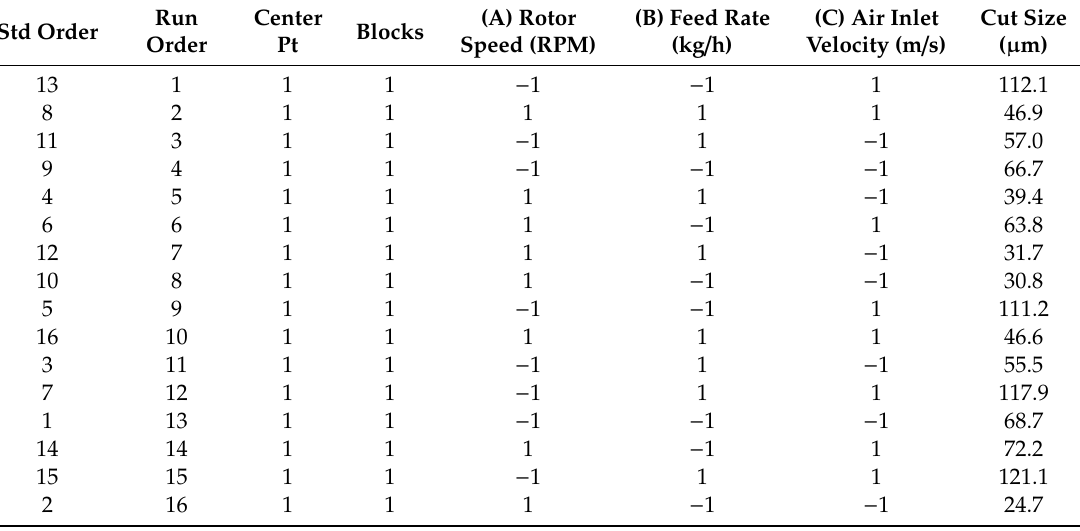
Table 2. The 2 3 -factorial experimental design with duplication and the results of cut size ( d 50 : average particle size at 50% cumulative volume percentage) from the